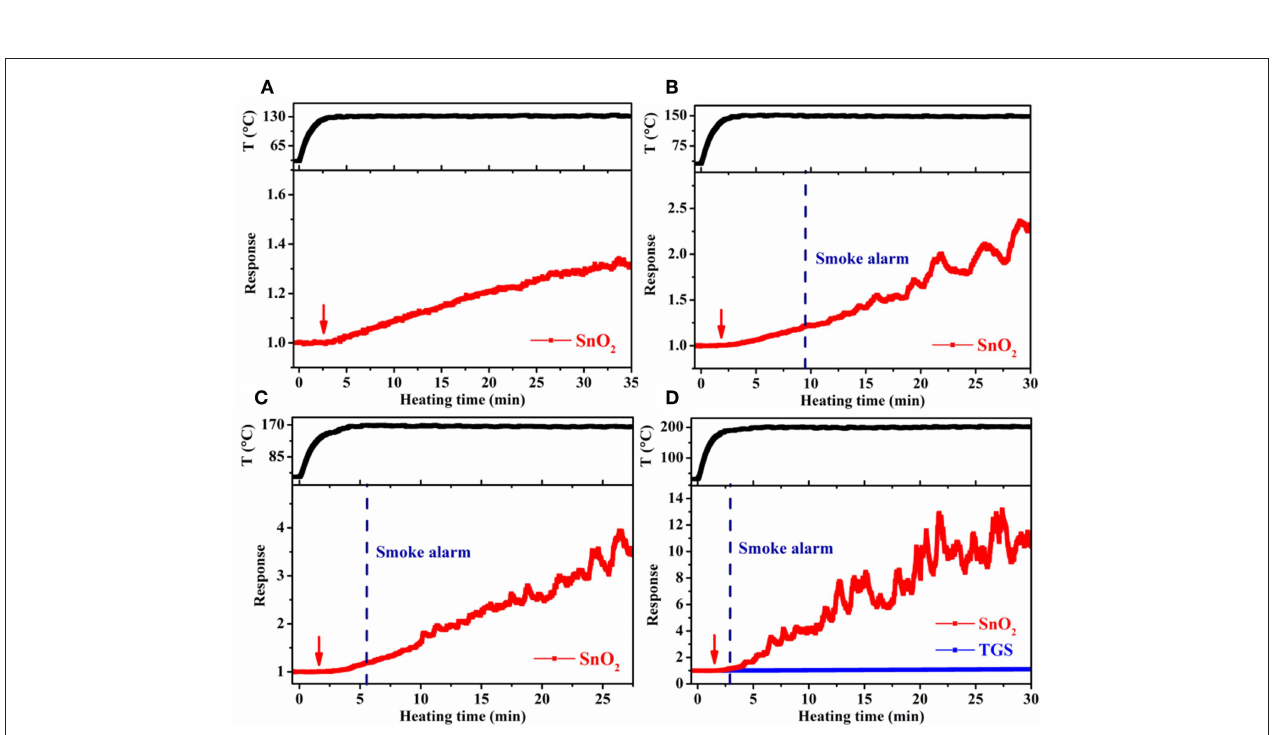
FIGURE 8 | Response of SnO 2 nanofiber sensor as a function of heating time at a cable temperature of (A) 130 ◦ C, (B) 150 ◦ C, (C) 170 ◦ C, and (D) 200 ◦ C during large-scale simulation tests for cable 4.